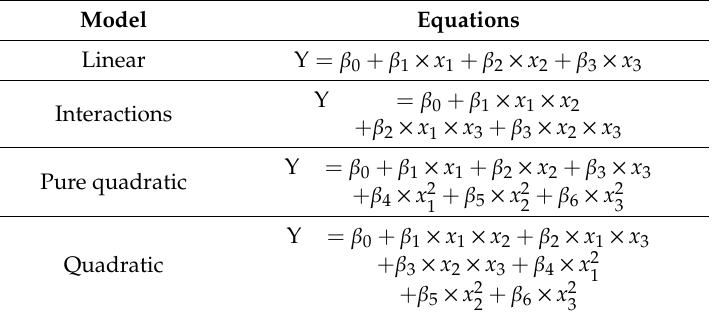
Table 1. Extension element model showing when islanding will occur.